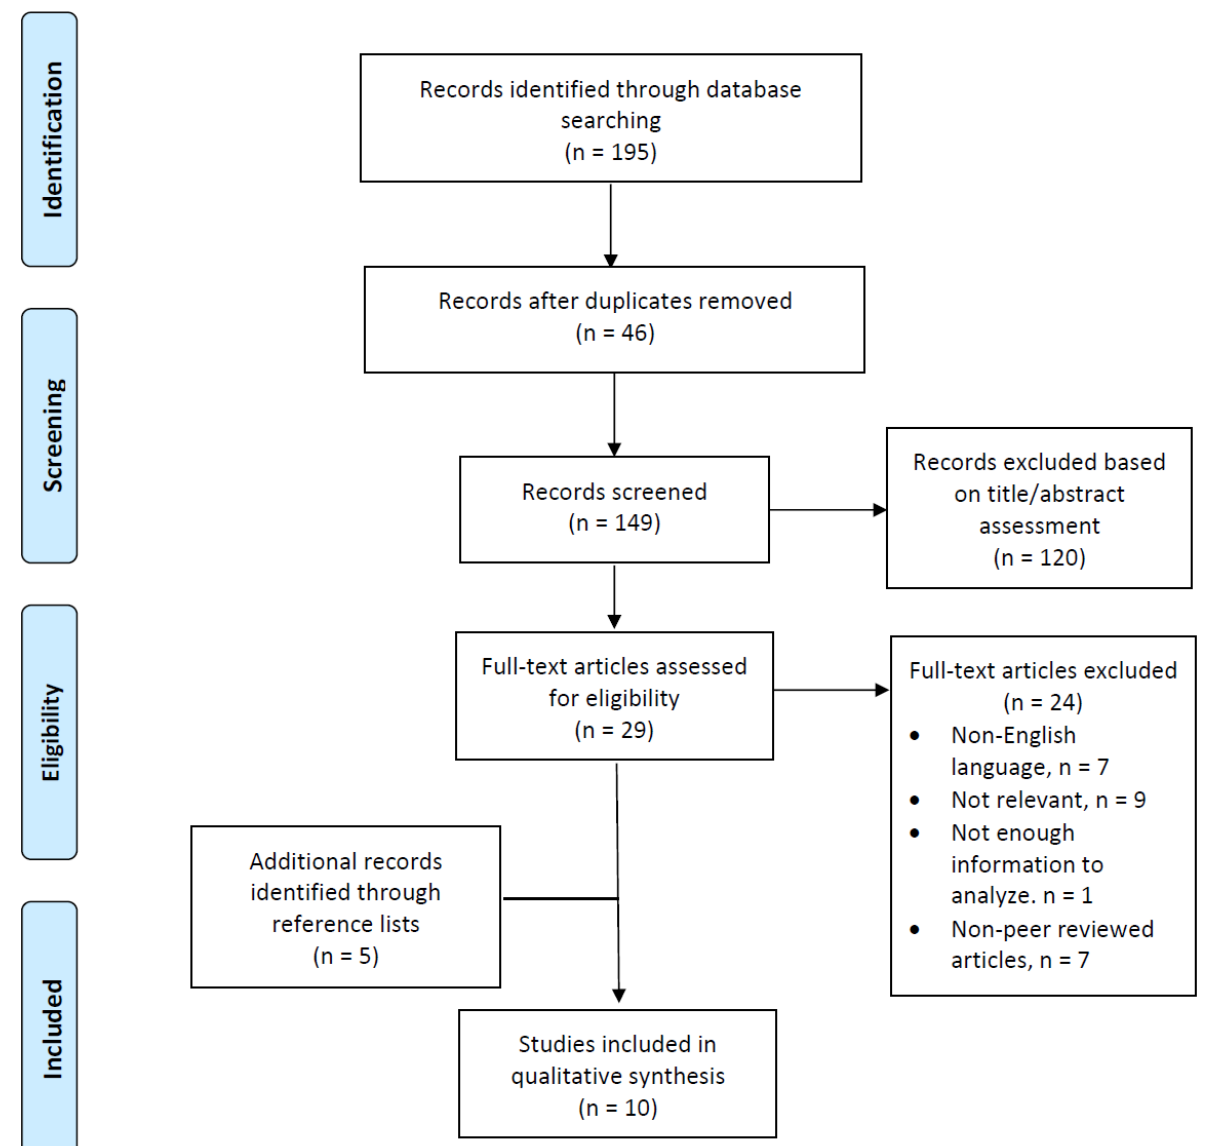
Figure 1. Scoping literature review flow chart (PRISMA).